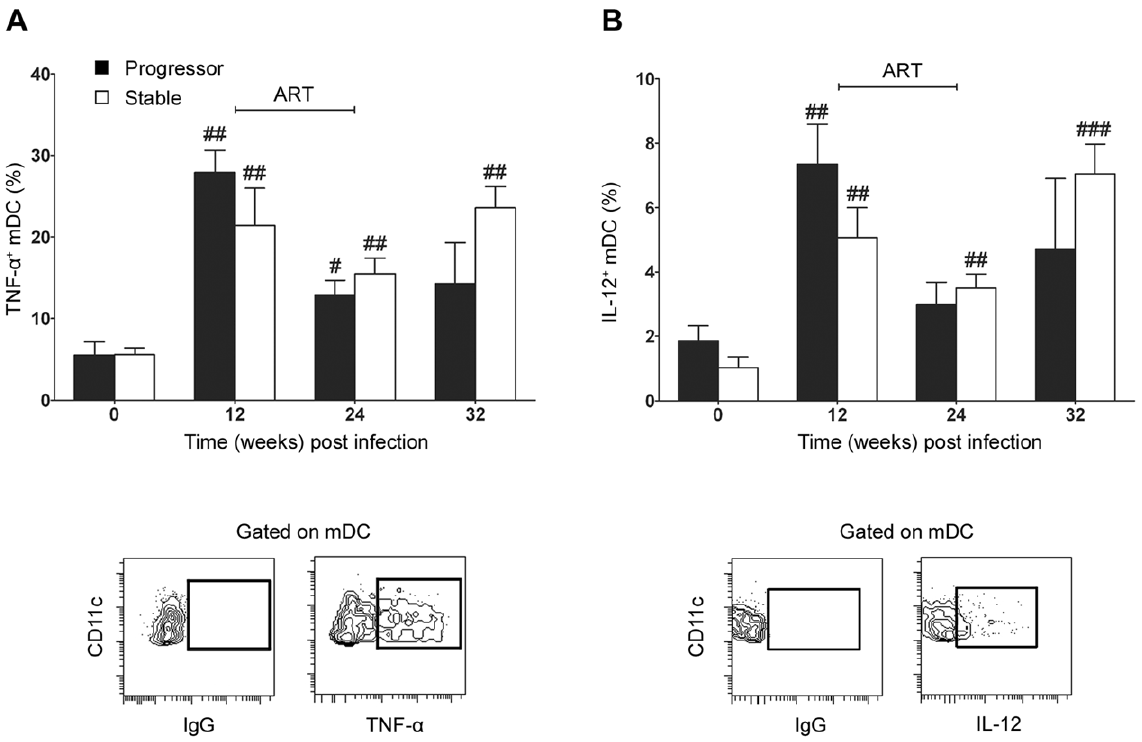
Figure 6. Lymph node mDC from SIV infected animals remain responsive to exogenous TLR8 stimulation. The proportion of lymph node mDC before and after SIV infection that express (A) TNF- a (A) or IL-12 (B) following stimulation with the TLR7/8 agonist 3M-007 for 5 hours. Shown are mean 6 SEM for naı¨ve (T=0, n=13), progressor (n=7) and stable animals (n=10). Also shown are representative flow cytometry plots of the gating strategy to identify positive populations. # P , 0.05, ## P , 0.01 within groups relative to week 0. ART=interval of antiretroviral